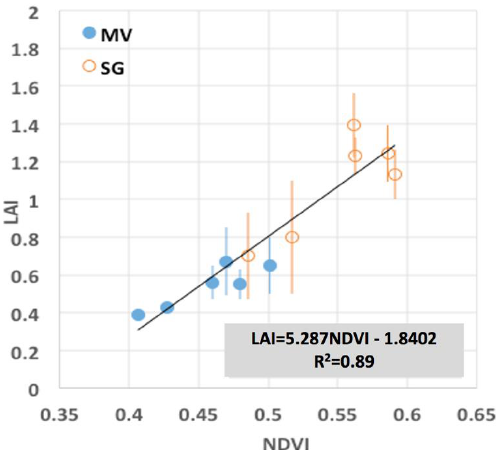
Figure 3. Correlation between normalized difference vegetation index (NDVI) and leaf area In- dex (LAI) for the two farms investigated. The error bars indicate the standard deviation of the measurements collected on each pair of transects.